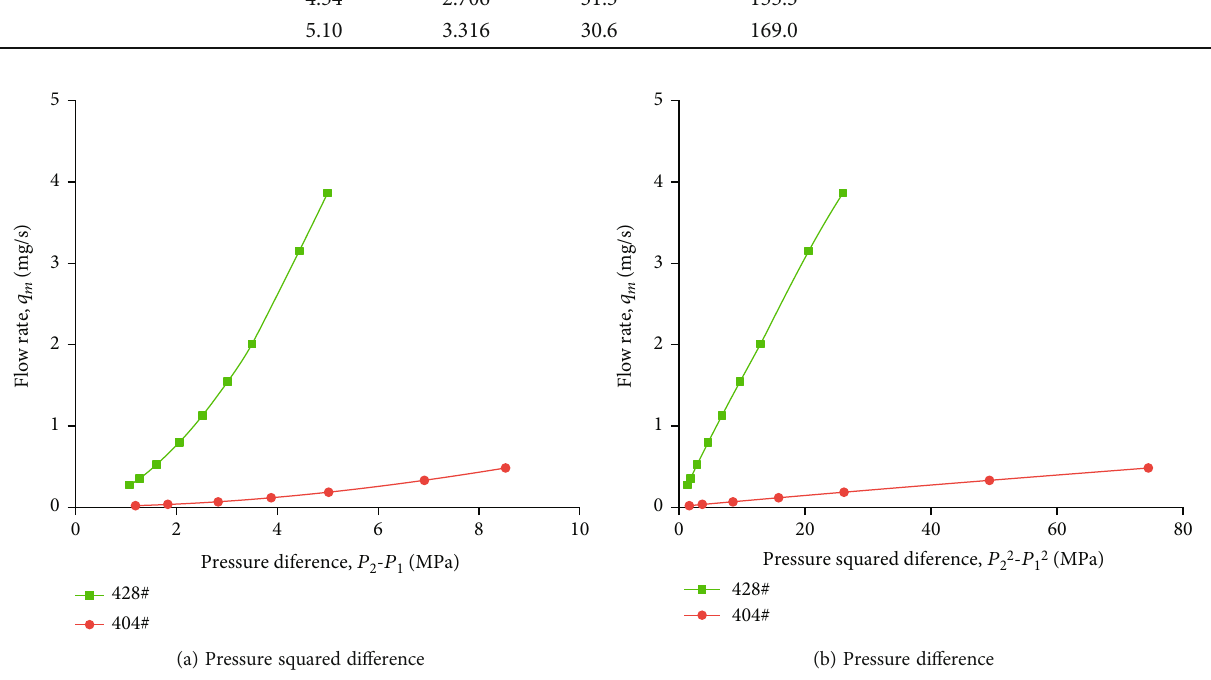
Figure 5: Shale gas fl ow test